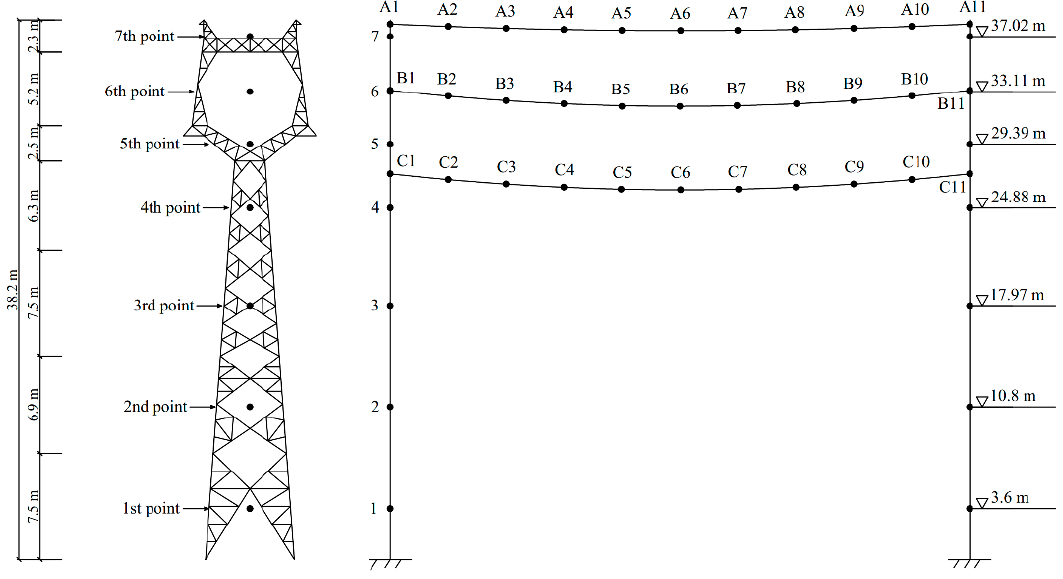
Figure 6. Schematic diagram of simplified wind load points.